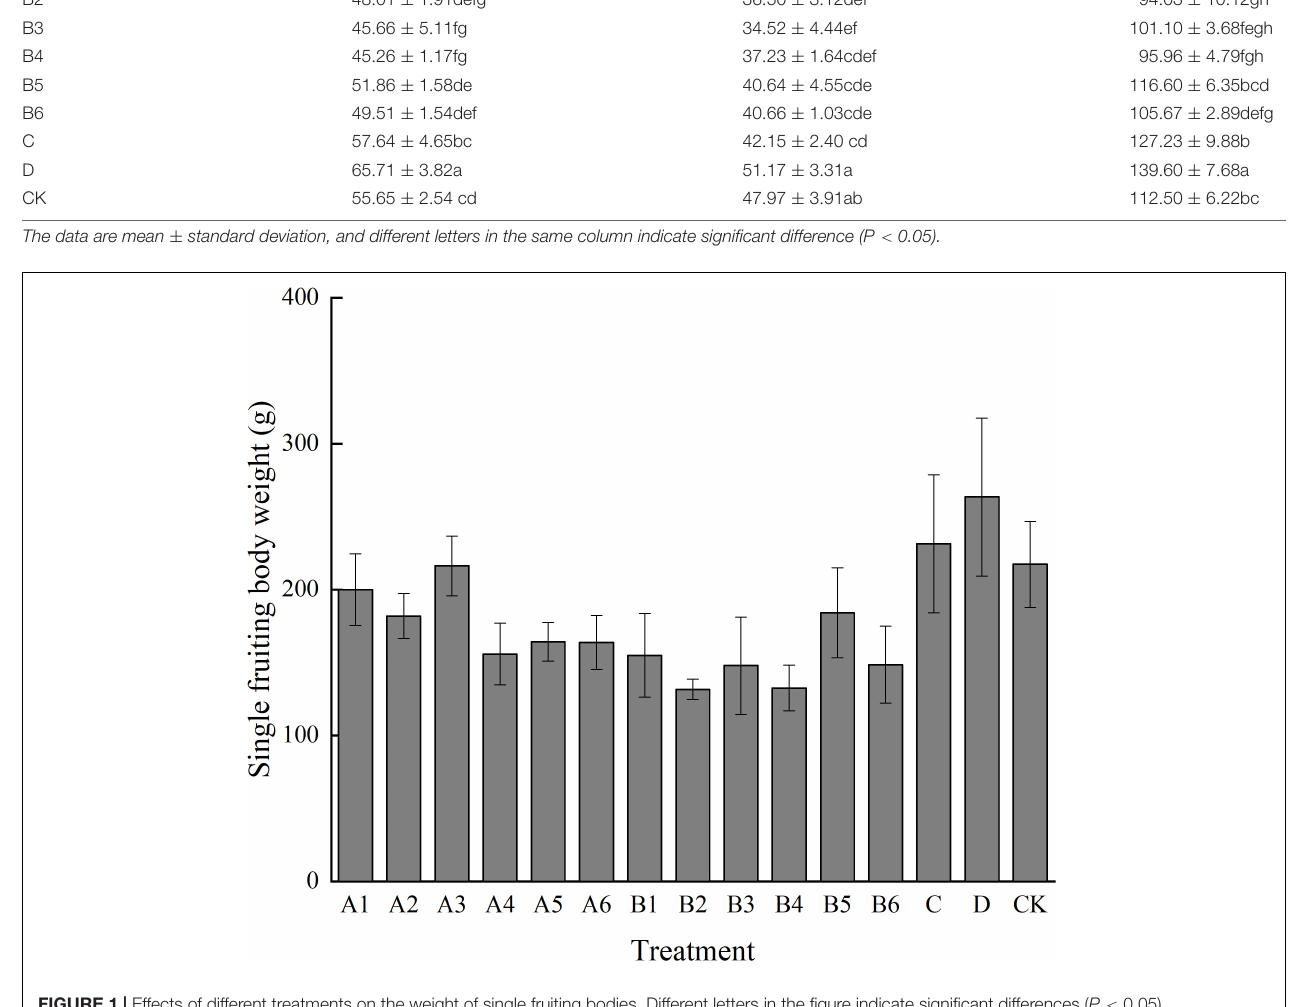
Compared with traditional methods, all three methods can be adopted to save labor